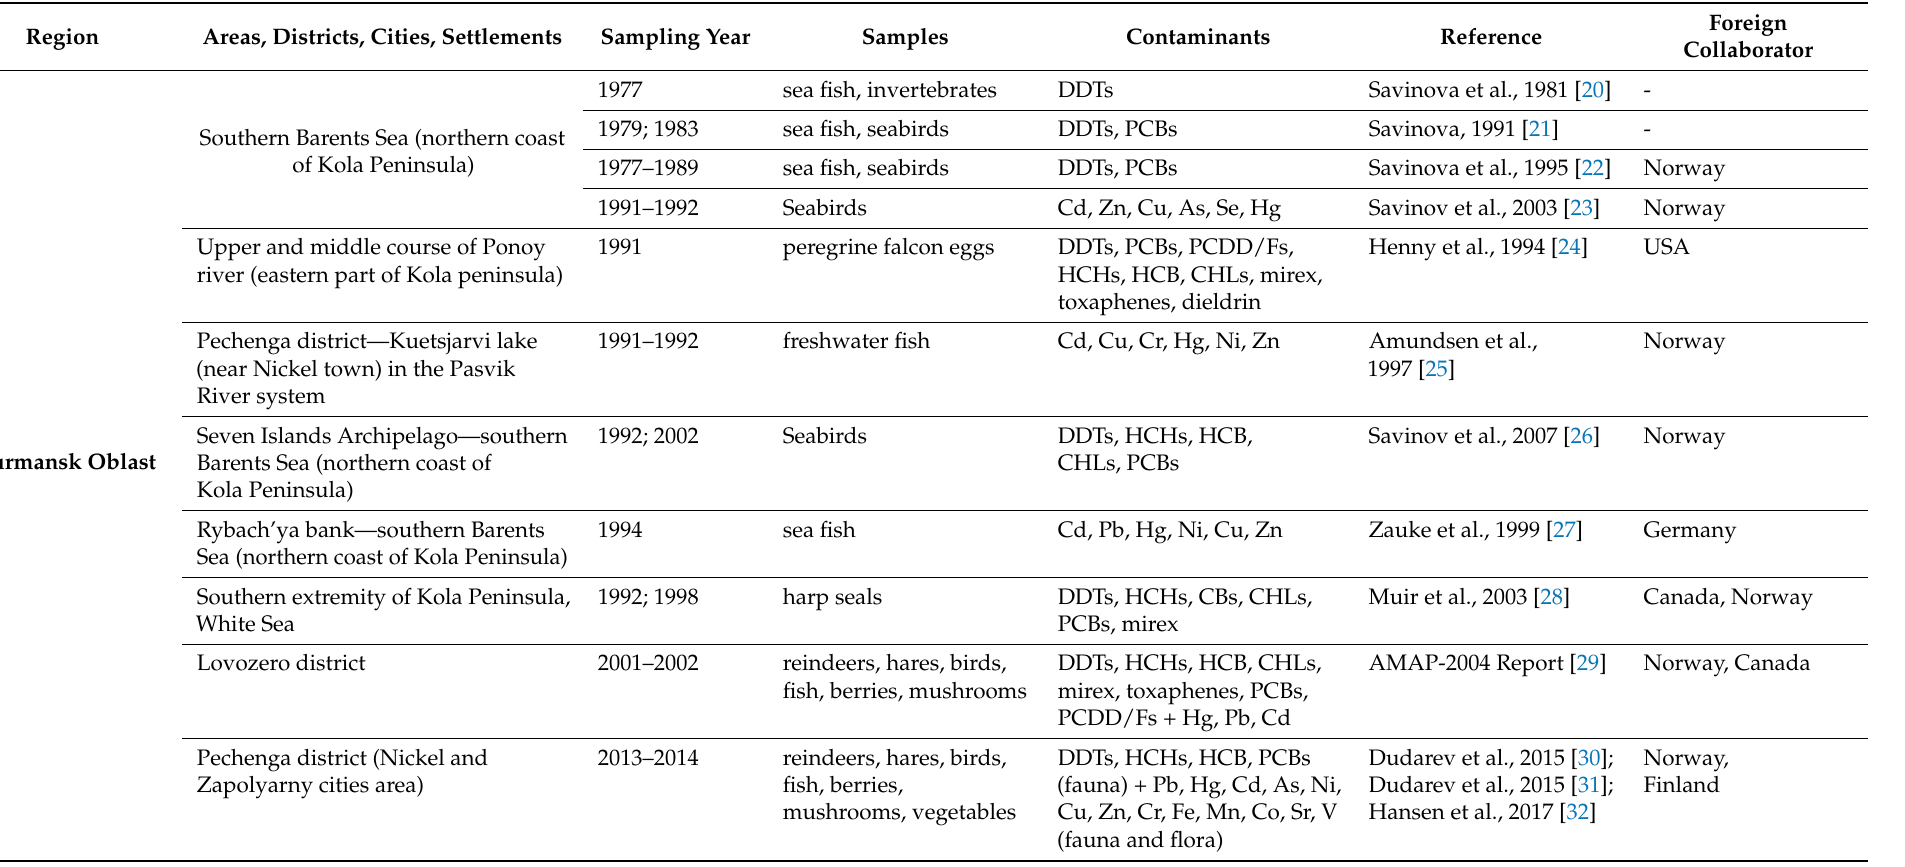
Table 1. Russian Arctic biomonitoring of contaminants in